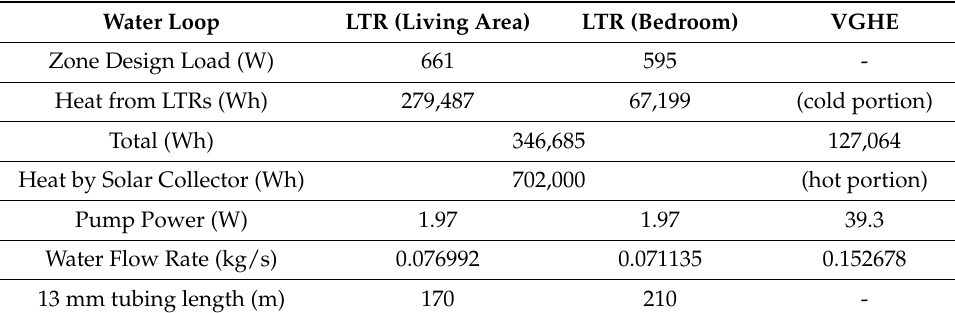
Table 5. Simulated Pump Power, Heat Extracted/Returned, Water Flow Rates.